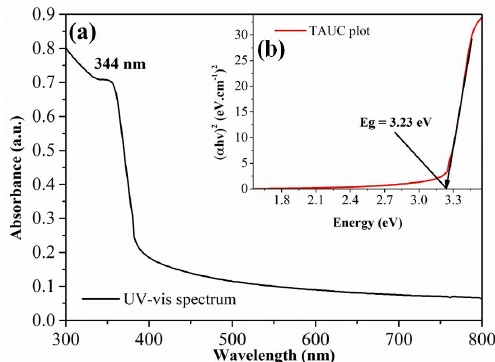
Figure 4. (a) UV-visible spectrum of the nanostructured ZnO and (b) TAUC plot